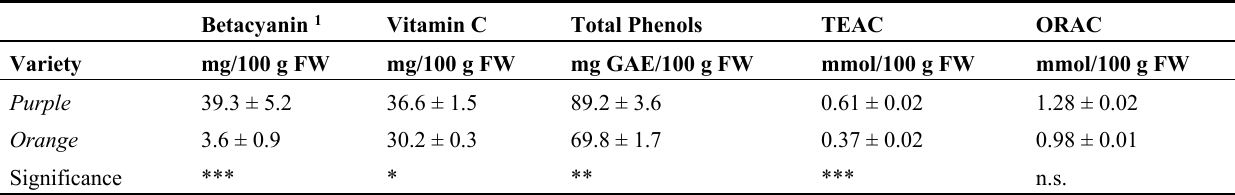
Table 2. Betacyanin, Vitamin C (AA + DHAA), Total Phenols, TEAC and ORAC values in a hydrophilic extract of cactus pear fruit pulp of different colors. Results are means ± S.D. ( n = 3). Betacyanin 1 Vitamin C Total Phenols TEAC ORAC Variety mg/100 g FW mg/100 g FW mg GAE/100 g FW mmol/100 g FW mmol/100 g FW Purple 39.3 ± 5.2 36.6 ±